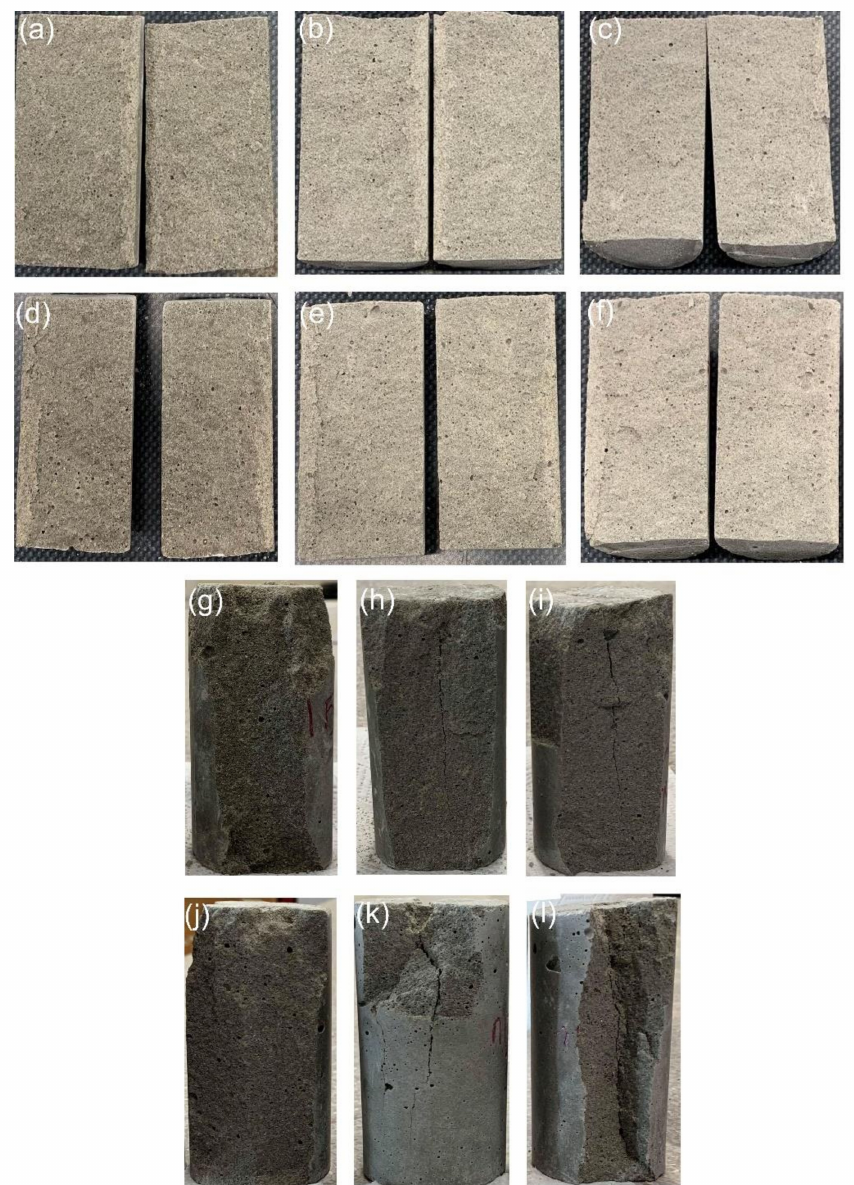
Figure 7. Sample images of the tested specimens’ ( a – c ) splitting tensile strengths (5–15% micro-Al 2 O 3 (MA)), ( d – f ) splitting tensile strengths (5–15% nano-Al 2 O 3 (NA)), ( g – i ) compressive strengths (5–15% MA) and ( j – l ) compressive strengths (5–15%